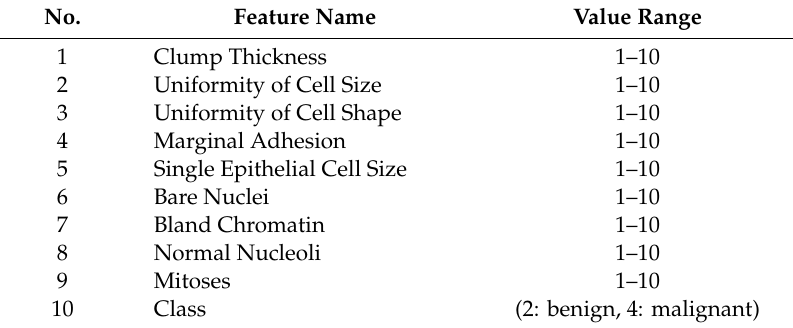
Table 1. Wisconsin Breast Cancer Diagnosis (WBCD) data summary.